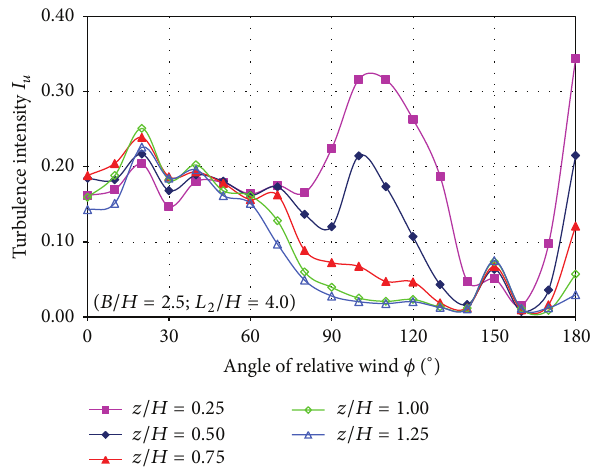
Figure 12: Turbulence intensity of the 𝑢 velocity component as a function of relative wind